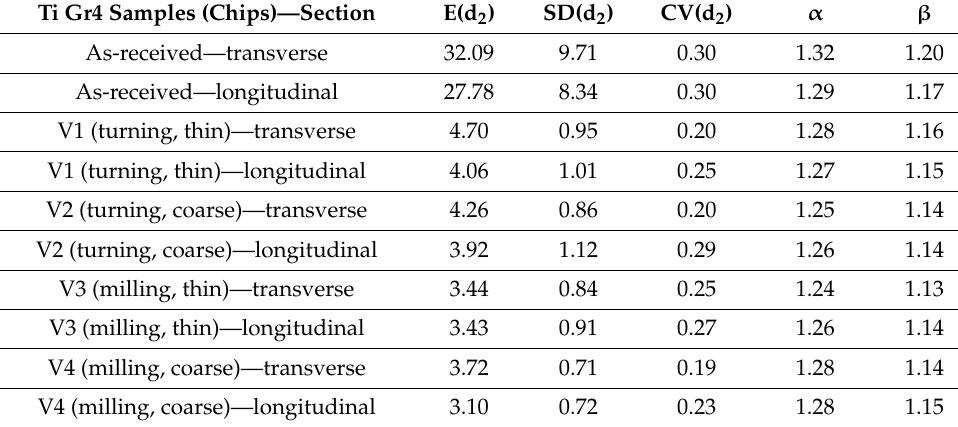
Table 8. Results of the stereological analysis of the microstructure of Ti Gr4, where: E(d 2 )—average grain size, SD—standard deviation, CV—coefficient of variation, α and β —shape factors (a descrip- tion of the stereological parameters is included in chapter “Investigation